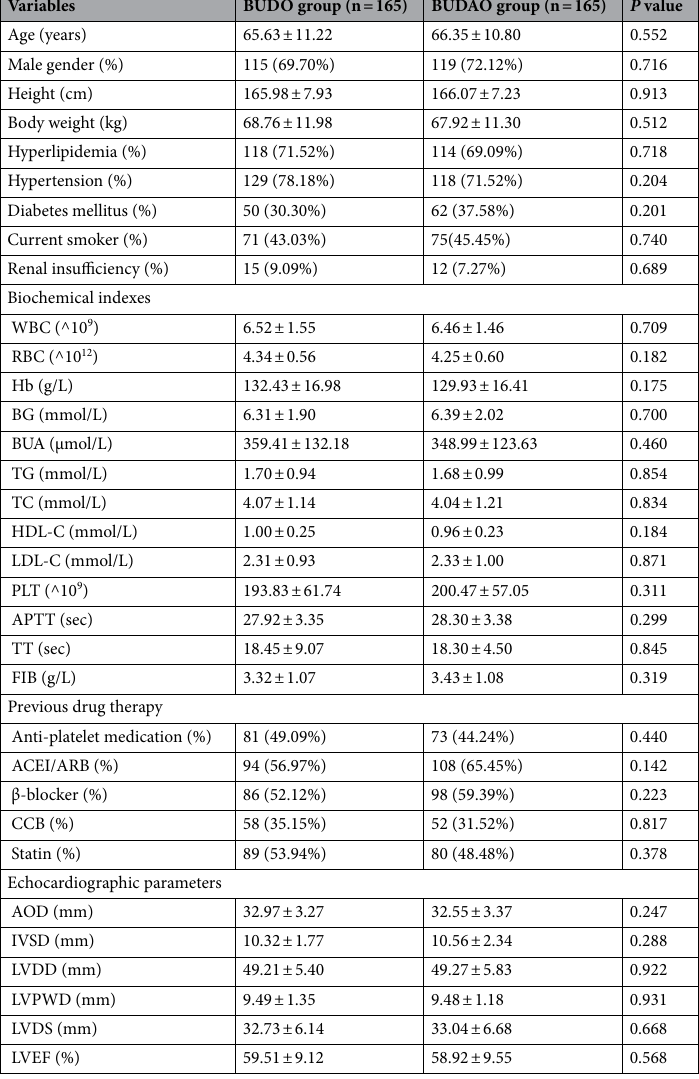
Table 1. Basic clinical characteristics in the BUDO and BUDAO groups. Data were expressed as n (%), mean ± SD. BUDO Bivalirudin use during operation; BUDAO Bivalirudin use during and after operation; WBC White blood cell; RBC Red blood cell; Hb Hemoglobin; BG Blood glucose; BUA Blood urine acid; TG Triglyceride; TC Total cholesterol; HDL-C High-density lipoprotein cholesterol; LDL-C Low-density lipoprotein cholesterol; PLT Platelet; APTT Activated partial thromboplastin time; TT Thrombin time; FIB Fibrinogen; ACEI / ARB Angiotensin-converting enzyme inhibitors/angiotensin receptor blockers; CCB calcium channel blockers; AOD Aortic diameter; IVSD Interventricular septum diameter; LVDD Left ventricular enddiastolic diameter; LVPWD Left ventricular posterior wall diameter; LVDS Left ventricular endsystolic diameter; LVEF Left ventricular ejection